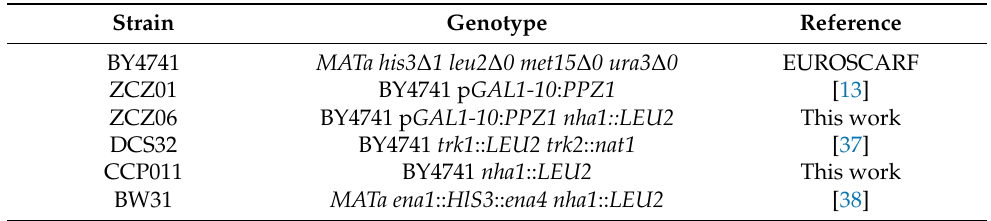
Table 1. Yeast strains used in this work. Strain